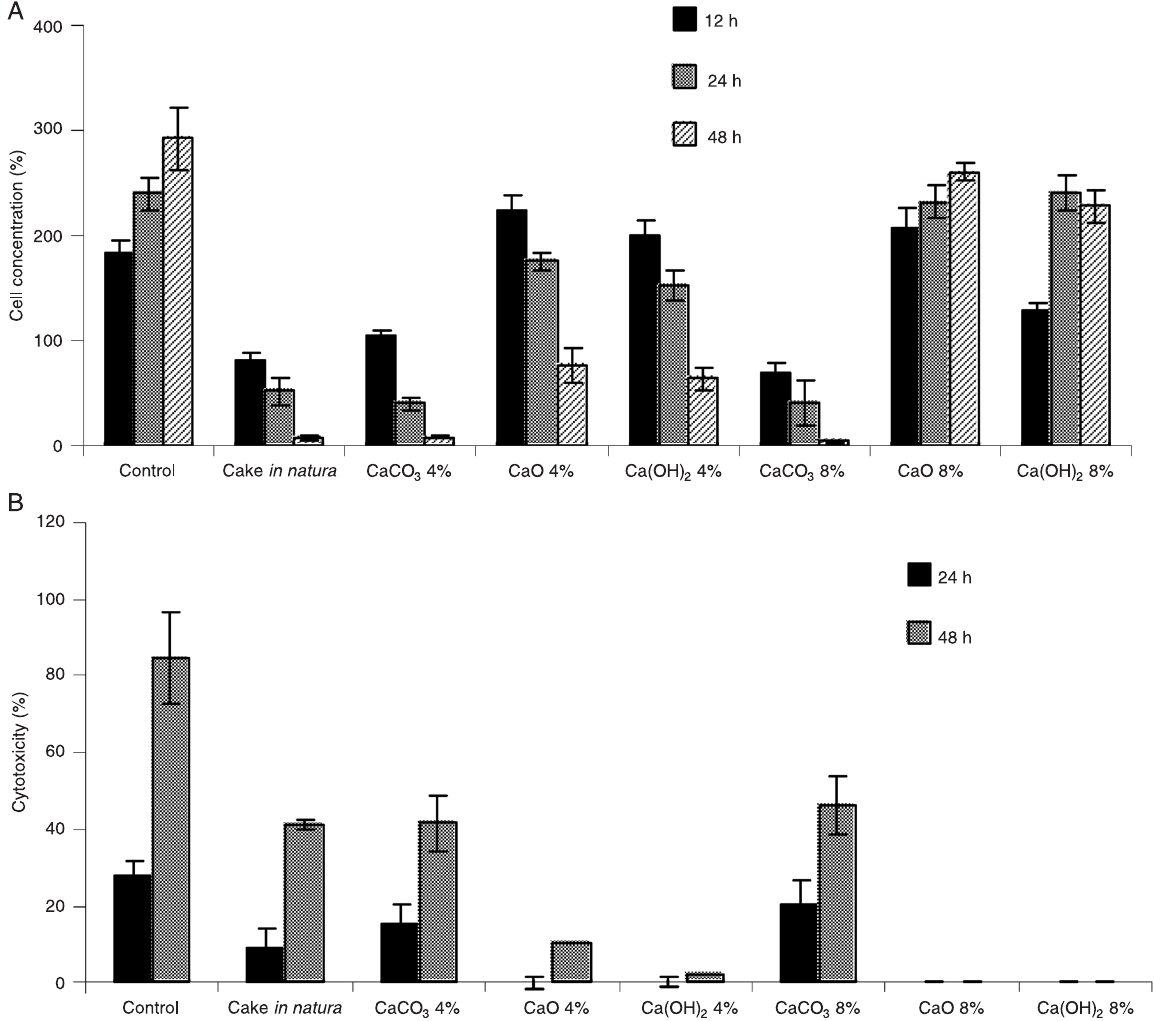
Figure 4. Toxicity of chemically treated castor cake. A , Vero cell viability. The initial cell concentration was 1.6 x 10 5 cells/well (100%). PBS, pH 7.0, was used as a negative control and crude in natura castor cake protein extract as a positive control. B , Lactate dehydro - genase activity in Vero cells incubated with castor cake treated with 4 or 8% CaCO 3 , CaO, or Ca(OH) 2 at a ratio of 1:1 (v/v). Data are representative of experiments performed in